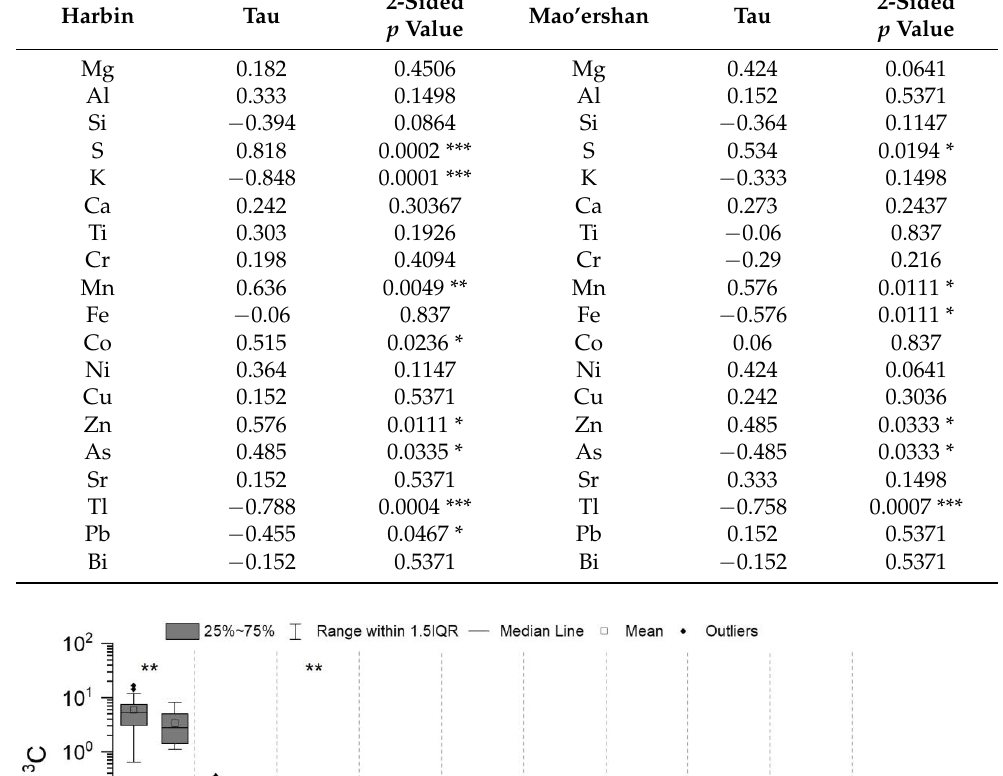
Figure 4 shows which chemical elements are significantly different when comparing their means between the Harbin and Mao’ershan sites. Tukey’s mean of comparisons test showed significant differences in Sr, Ni, Tl and As ( p < 0.001), in K and Mg ( p < 0.01), and in Cr and Pb ( p < 0.05).